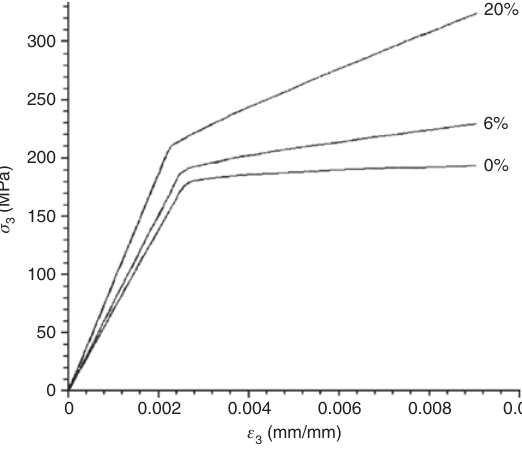
Figure 6: Stress-strain response of composite with different volume fractions of